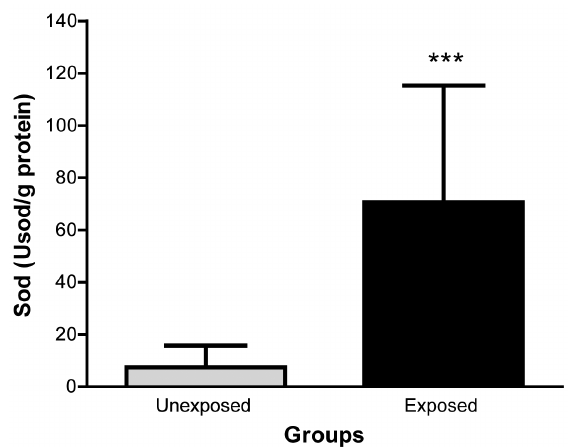
Figure 2 - Superoxide dismutase activity in the unexposed and exposed groups. *** Signi fi cant at P<0.001 in relation to unexposed group; Student t-